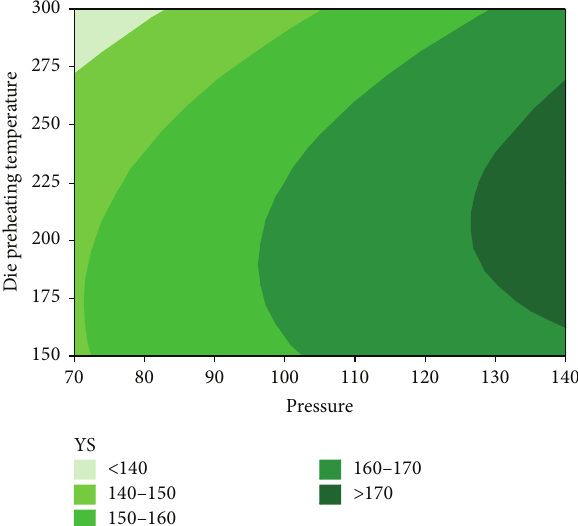
Figure 14: Contour plot for YS versus die preheating temperature and pressure.